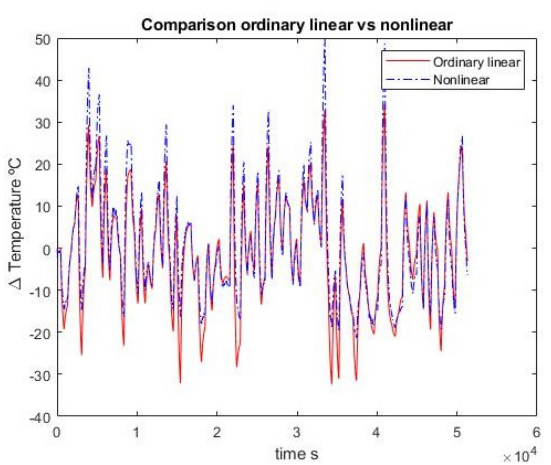
Figure 9. First-order models comparison with validation data.